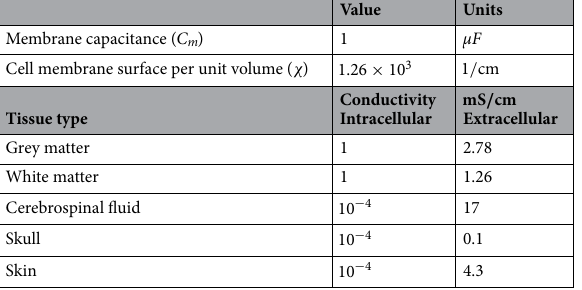
Table 2. Physical